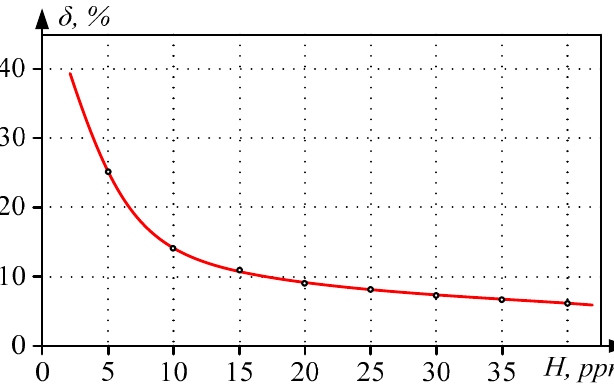
Figure 8. The relative error at H